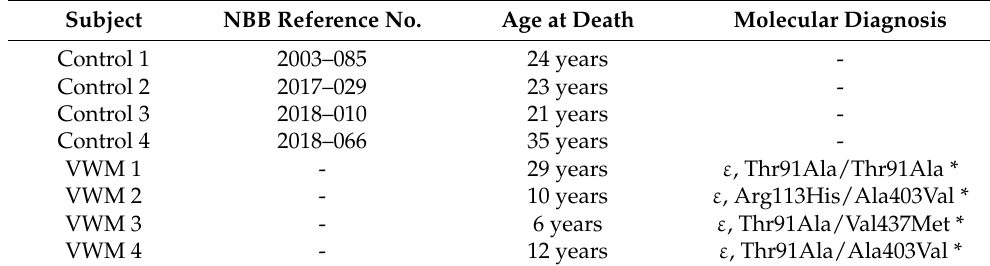
Table 1. Demographic features of controls and